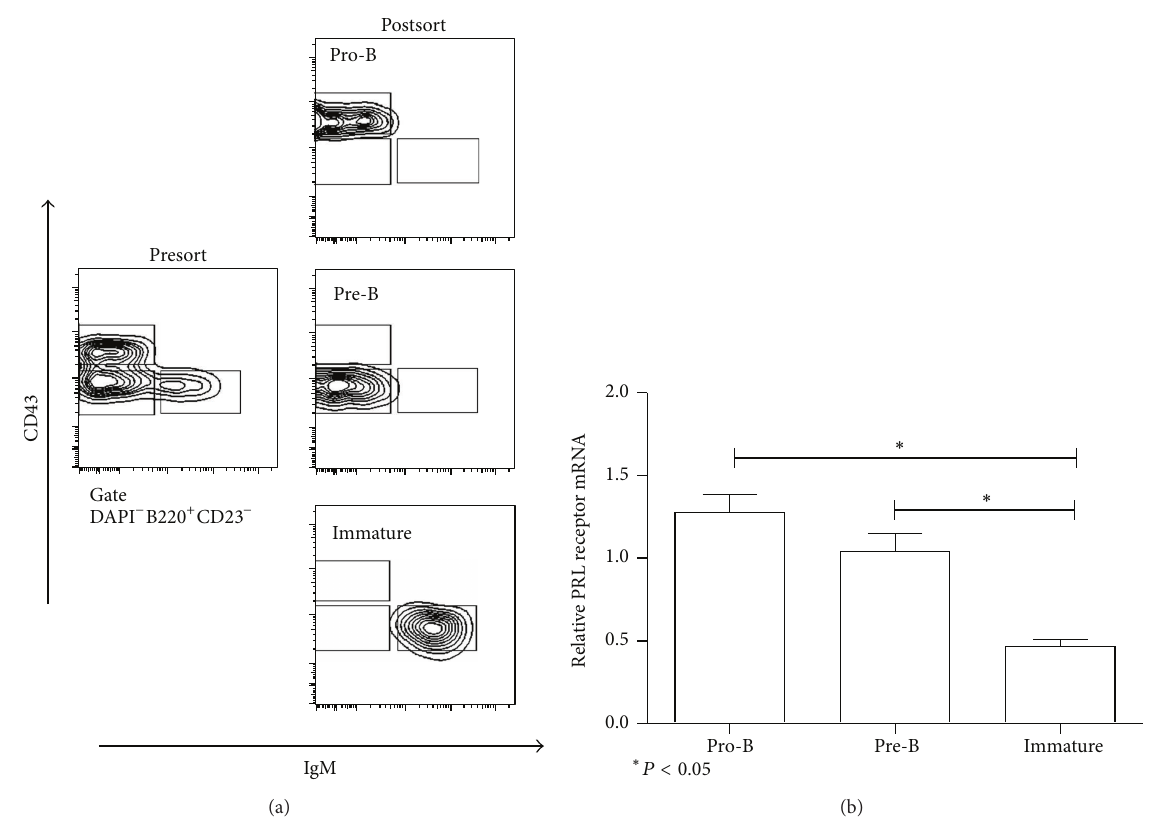
Figure 1: Purification of B cell by flow cytometry. B cells were purified from the BM of 9-week-old mice. (a) The cells were incubated with antibodies specific for B cell subsets, and the subsets were purified using flow cytometry, as detailed in Methods. The purity of the collected populations varied between 95% and 98%. A representative example of the purified B cells from wild-type C57BL/6 mice is shown. (b) Using RT-PCR, the PRL receptor mRNA expression was measured in the different subsets of bone marrow B cells (pro-B, pre-B and immature). The asterisks denote statistical significance with the 𝑃 value